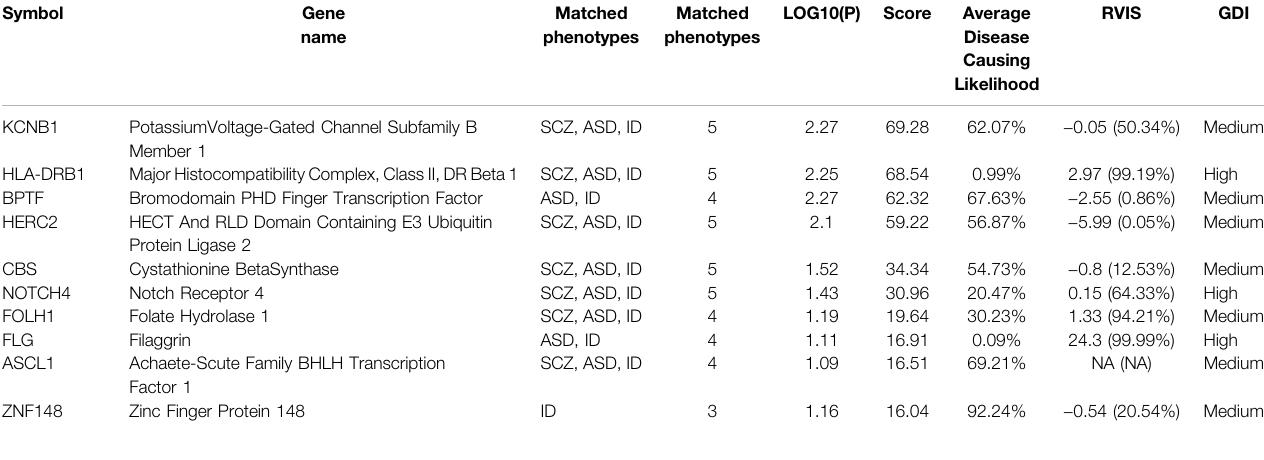
TABLE 2 | The fi rst 10 best scored genes according to VarElect predictor. SCZ, Schizophrenia; ASD, Autism Spectrum Disorder; ID, Intellectual